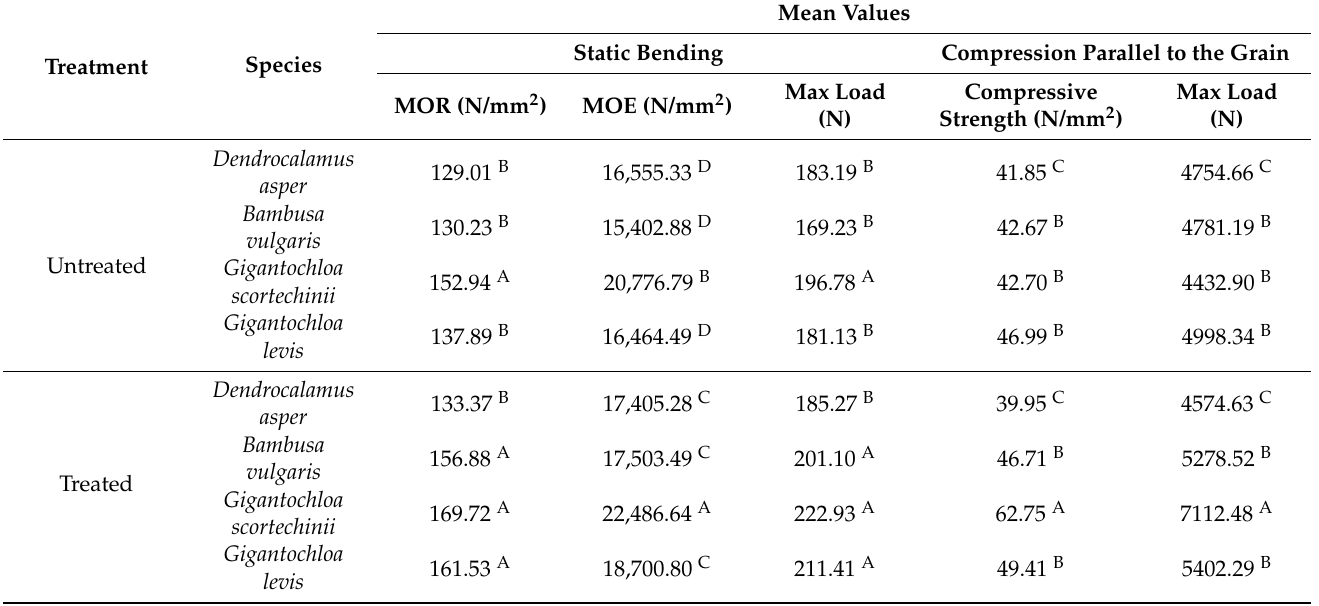
Table 7. Mean values for the mechanical properties of untreated and treated bamboo strips from different species.